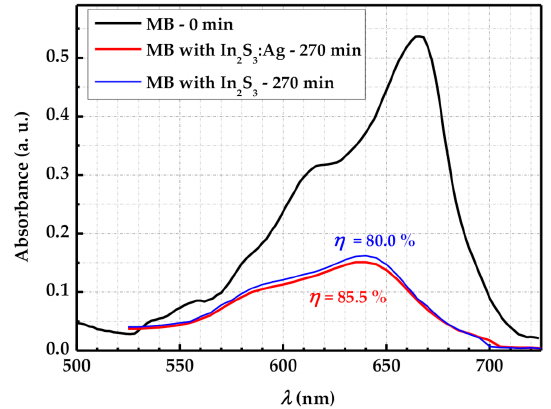
Figure 7. Absorbance spectra of a solution containing the as-prepared methylene blue (MB) solution and after VIS (visible spectrum) irradiation in the presence of the doped and undoped indium sulfide films, during 270 min. The photodegradation efficiencies are referred in the